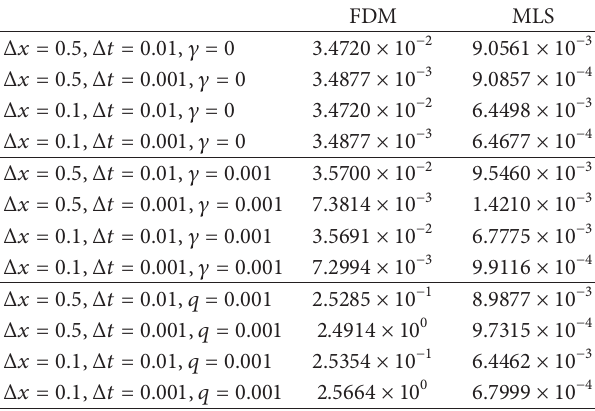
Table 5: The errors for different Δ𝑥 , Δ𝑡 and noisy